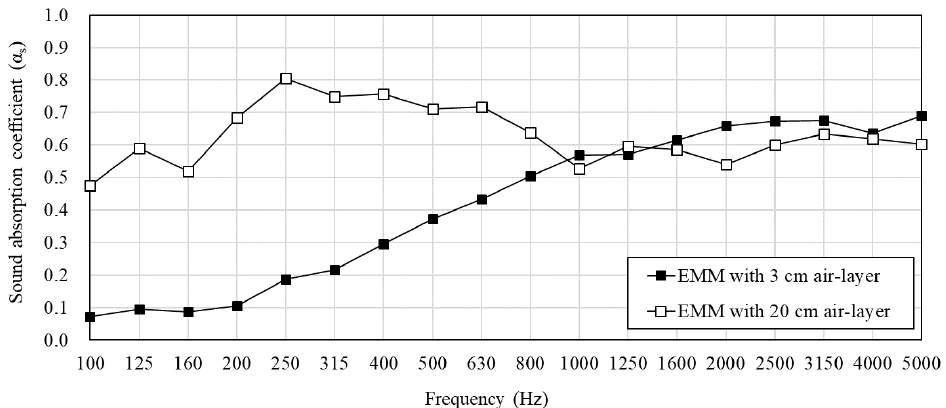
Figure 7. The sound absorption coefficient of expanded metal mesh (EMM) with single-layer structure in stage 1.